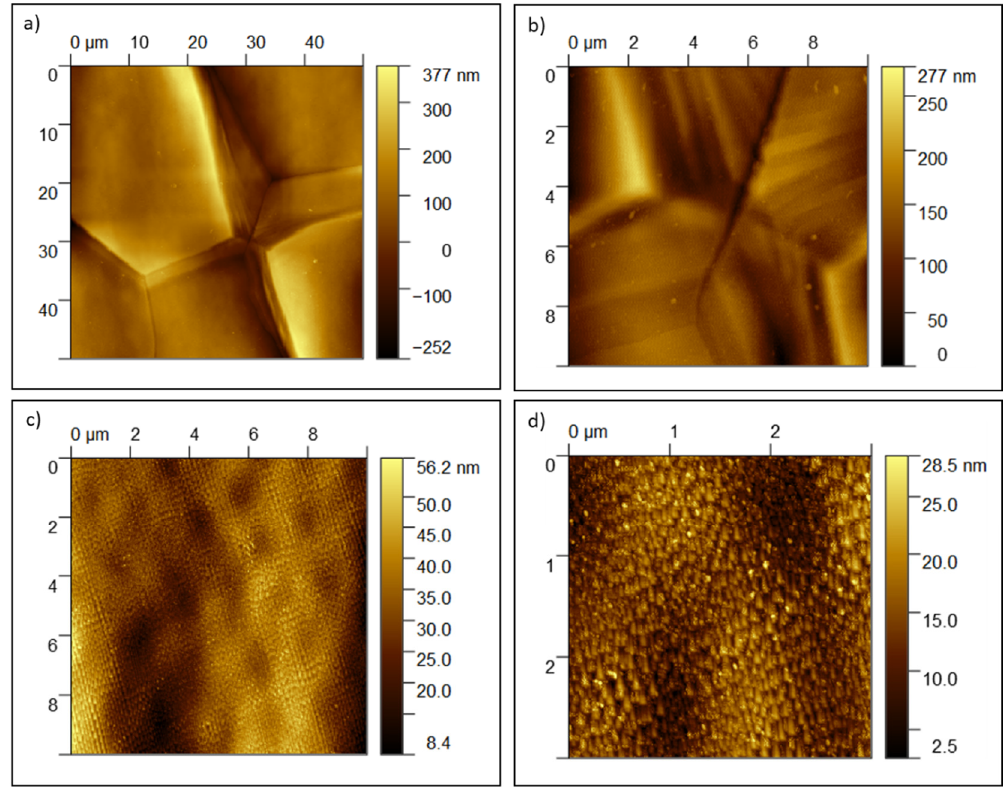
Figure 4. AFM images of Ti15Mo-EB10 surface: ( a ) topography of different grains with growth bands at grain boundaries (50 × 50 µm scan); ( b ) higher magnification of the growth bands in Figure 4a (10 × 10 µm scan); ( c ) nanosteps in the center of a grain ((10 × 10 µm scan); ( d ) detail of the nanosteps’ texture (3 × 3 µm scan)